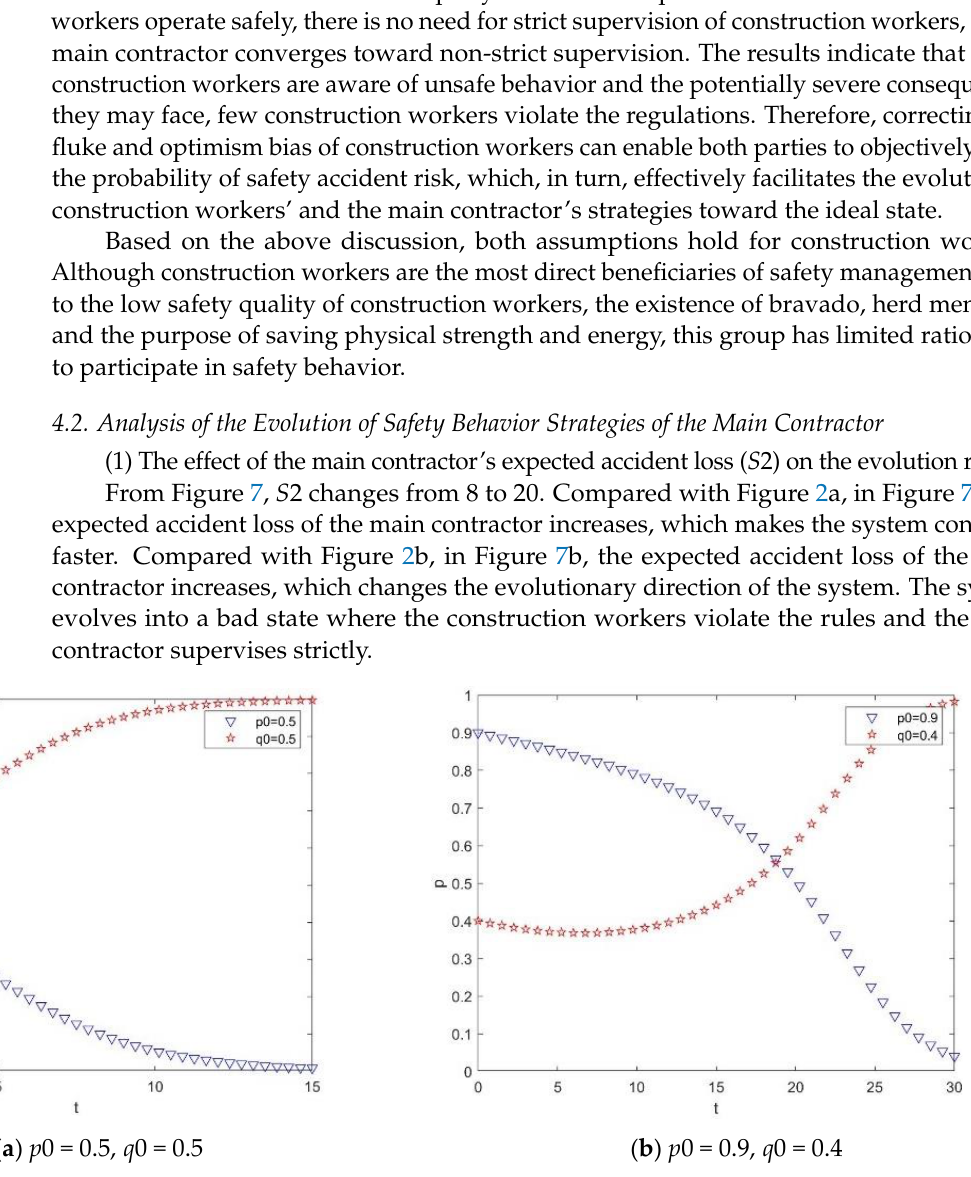
Figure 7. The effect of the main contractor’s expected accident loss S 2 on the evolution results.